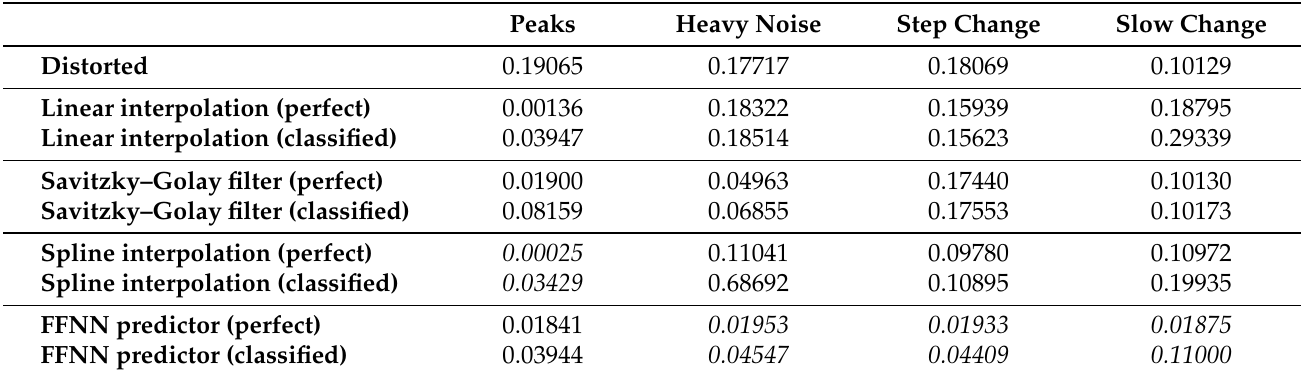
Table 3. RMSE after reconstruction with different methods (with perfect and algorithmic artifact classifications) for the mocap sequence with a 5% distorted time in the sequence.